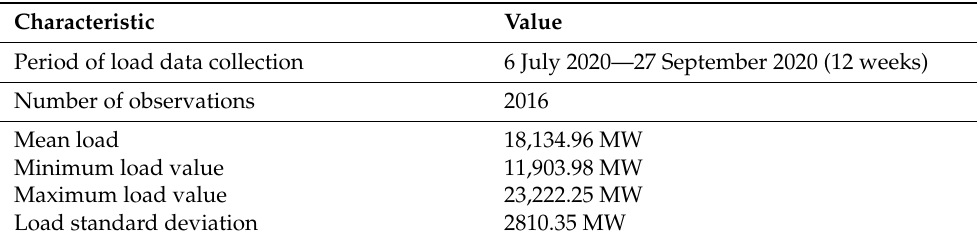
Table 3. Basic characteristics of data used in the